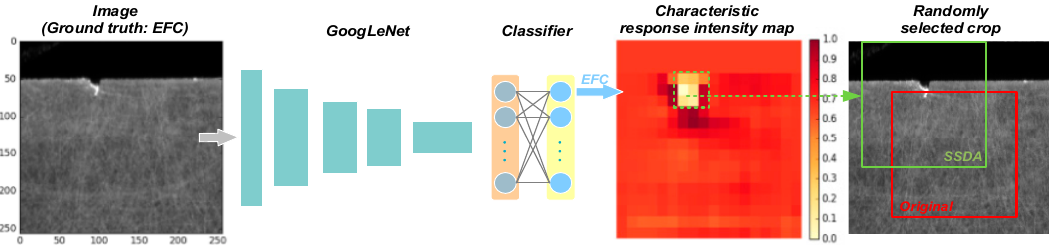
Figure 3. Flowchart of the proposed semi-supervised data augmentation (SSAD) method.